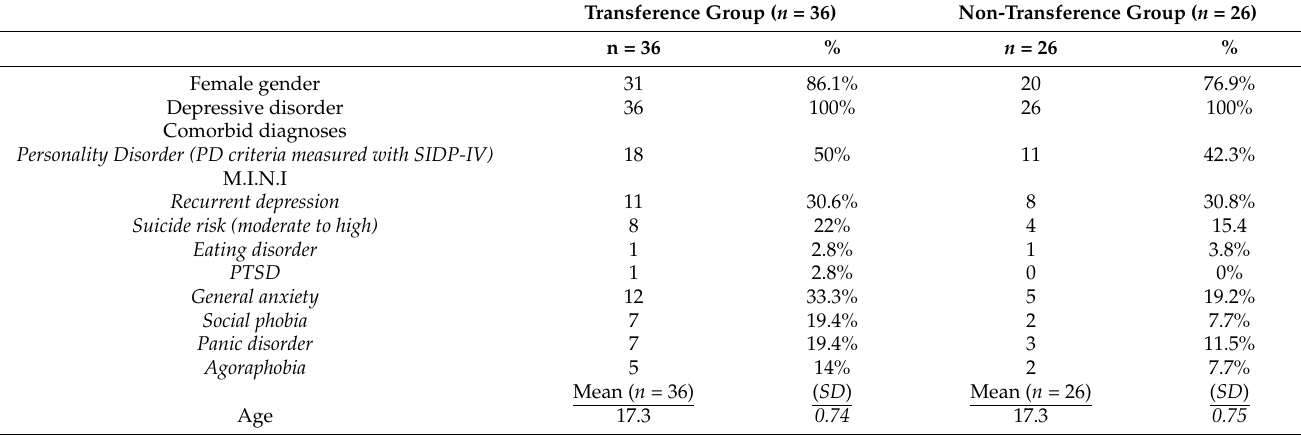
Table 1. Pre-treatment characteristics of depressed adolescents included in the First Experimental Study Transference Work—In